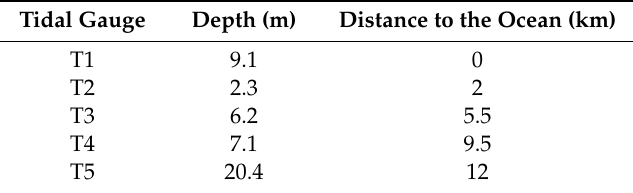
Table 8. Depth (in metres referred to the MSL) of the considered numerical tidal gauges and distance to the ocean (km).